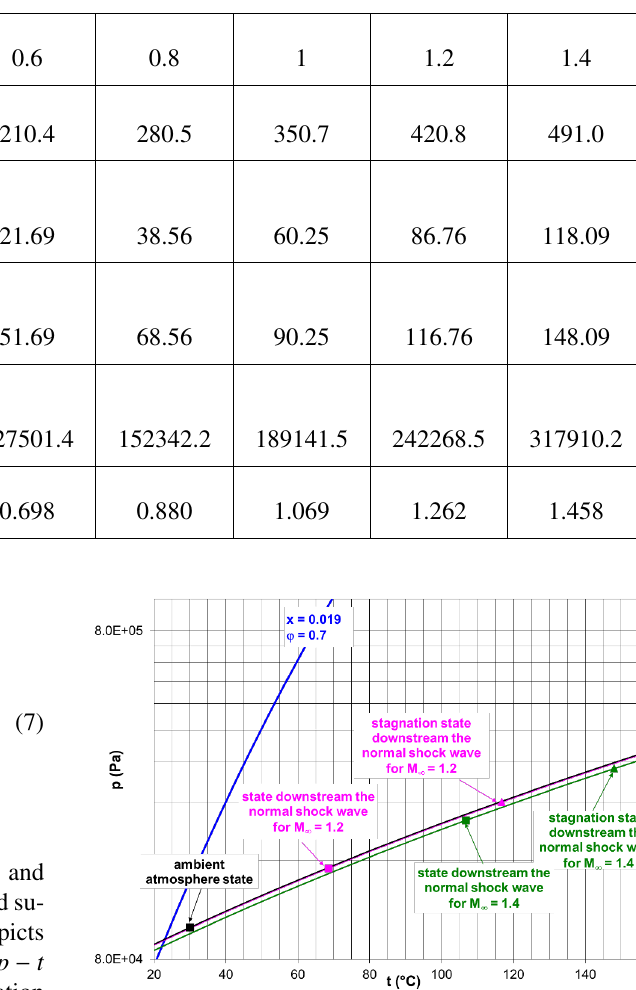
Fig. 7. p − t phase diagram of the moist air with the specific humidity x = 0 . 0019 kg V / kg DA and the isentrope ( s = const . ) crossing the point of the state t a = 30 ◦ C, p a = 0 . 1 MPa and ϕ = 70% with the marked state downstream the normal shock wave and its corresponding stagnation state for aircraft Mach numbers M ∞ = 1 . 2 and 1 . 4